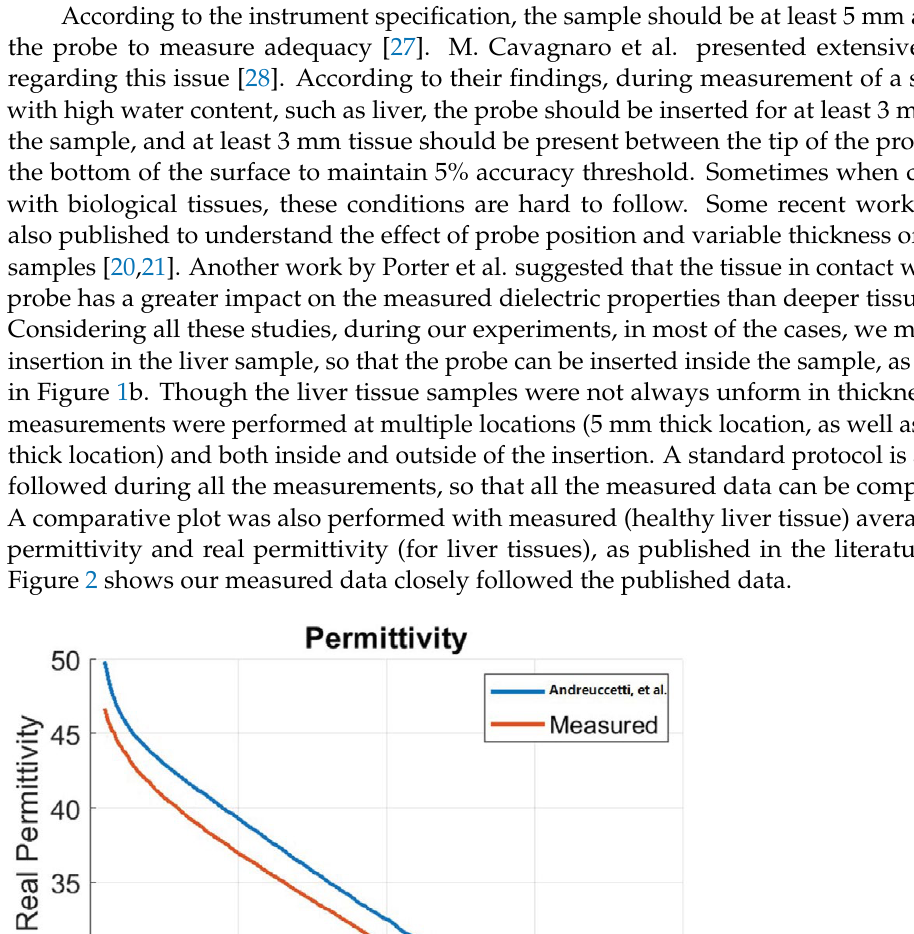
( b ) Figure 1. ( a ) Laboratory setup for the dielectric spectroscopy measurements using opened coaxial probe method at room temperature and ( b ) probe inserted into the sample under investigation.